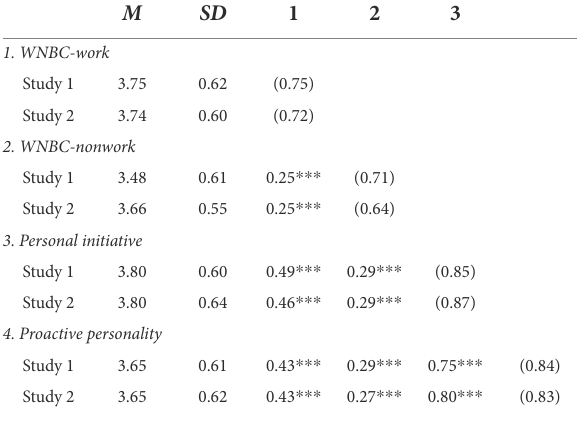
TABLE 3 Partial correlations and McDonald’s ω (between brackets on the diagonal) among the WNBC dimensions and personal initiative and proactive personality (controlled for gender, age, education level, and vocational position).